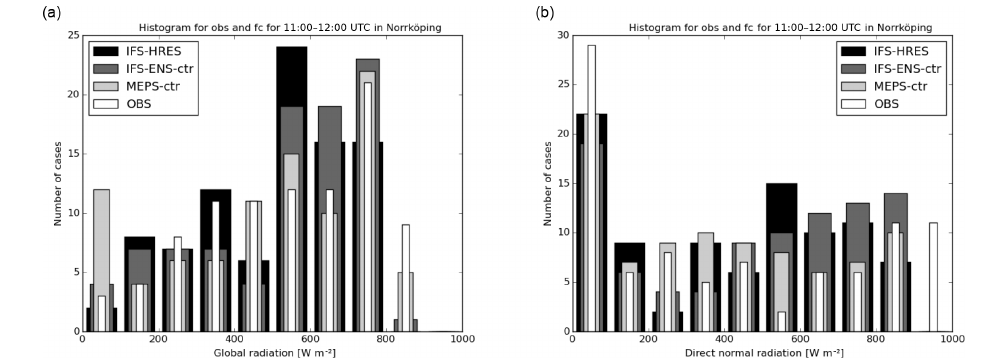
Figure 1. Histograms with modelled forecasted (fc) and measured (obs) GHI (left) and DNI (right) for the hour 11:00–12:00UTC